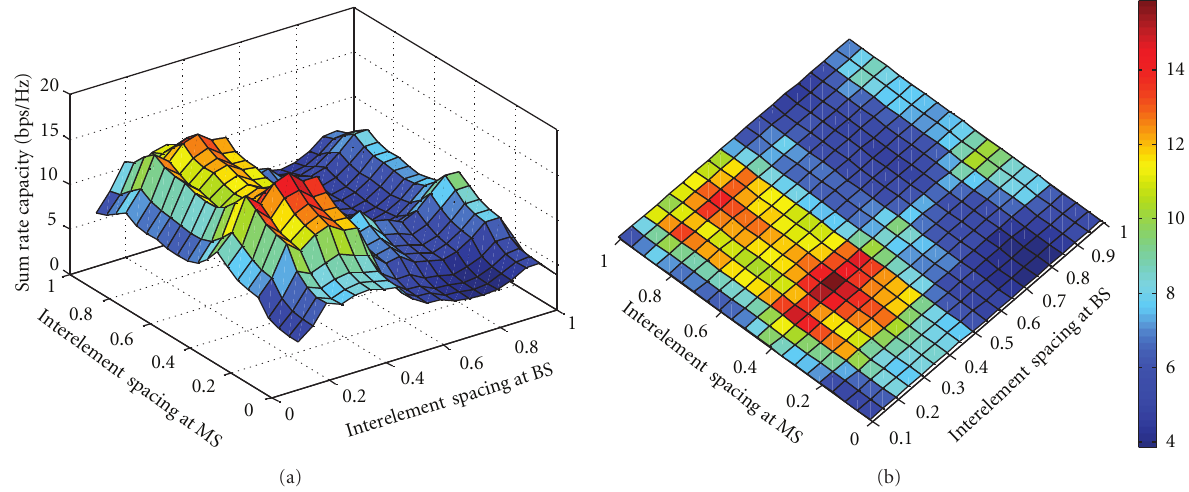
Figure 8: Surface of sum rate capacity with transmit and receive spatial correlation and mutual coupling for a 2 × (3 × 6) multiuser MIMO system at SNR = 20